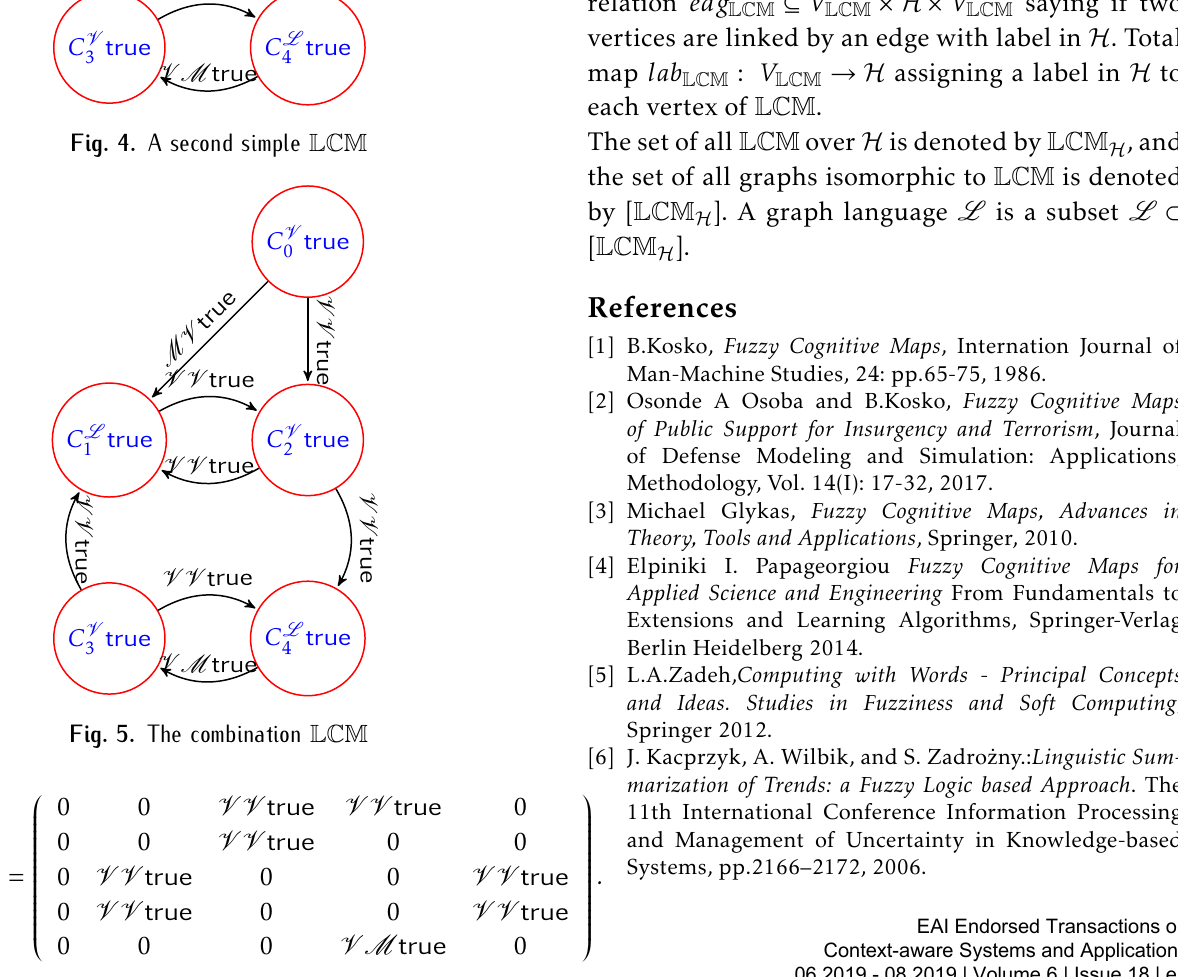
Fig. 3. A first simple LCM